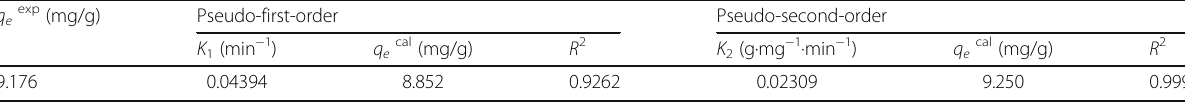
Table 1 Kinetics adsorption parameters of Cd 2+ by Fe 3 O 4 @PDA q e exp (mg/g)